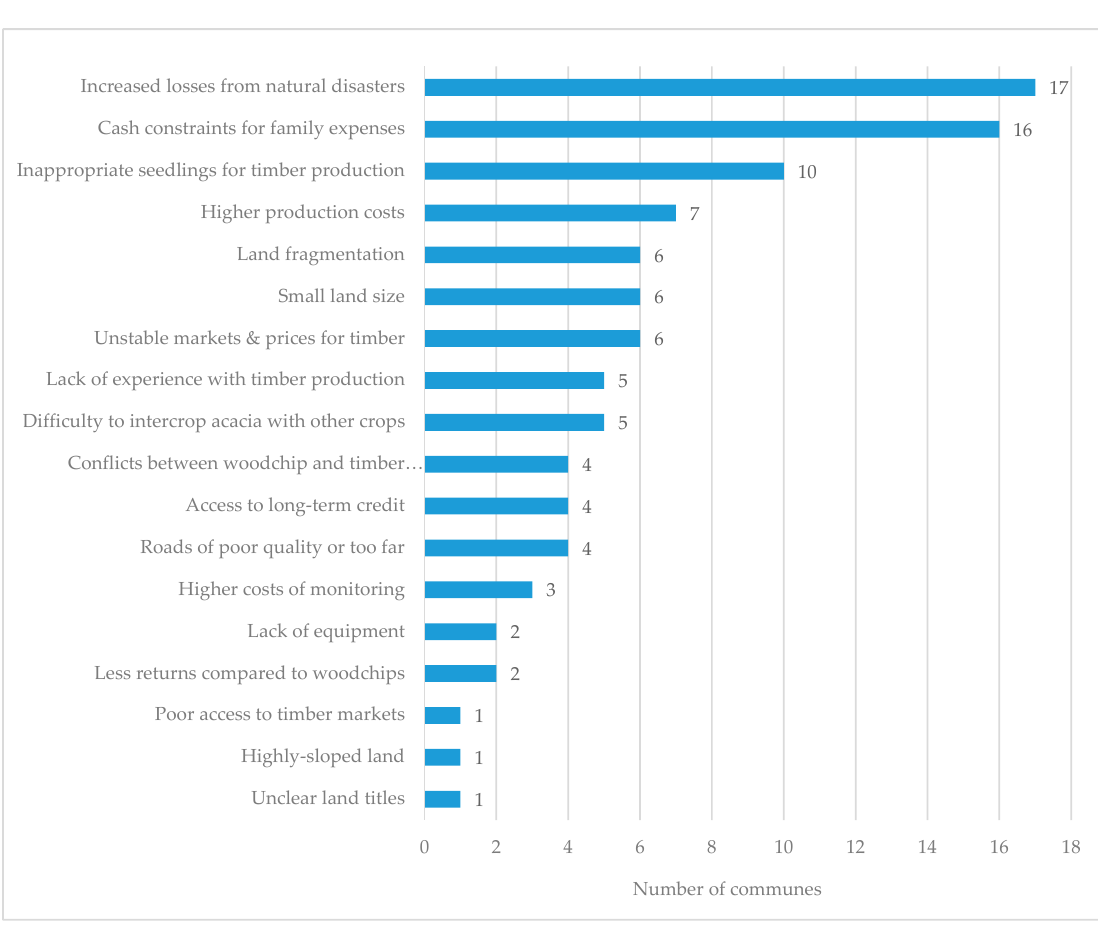
Figure 2. Potential disincentives to produce sawlogs as indicated by acacia plantation owners. Source: Data from focus group discussions.